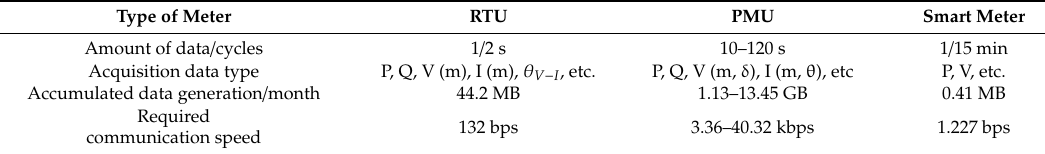
Table 1. Monthly amount of accumulated data for each terminal unit.